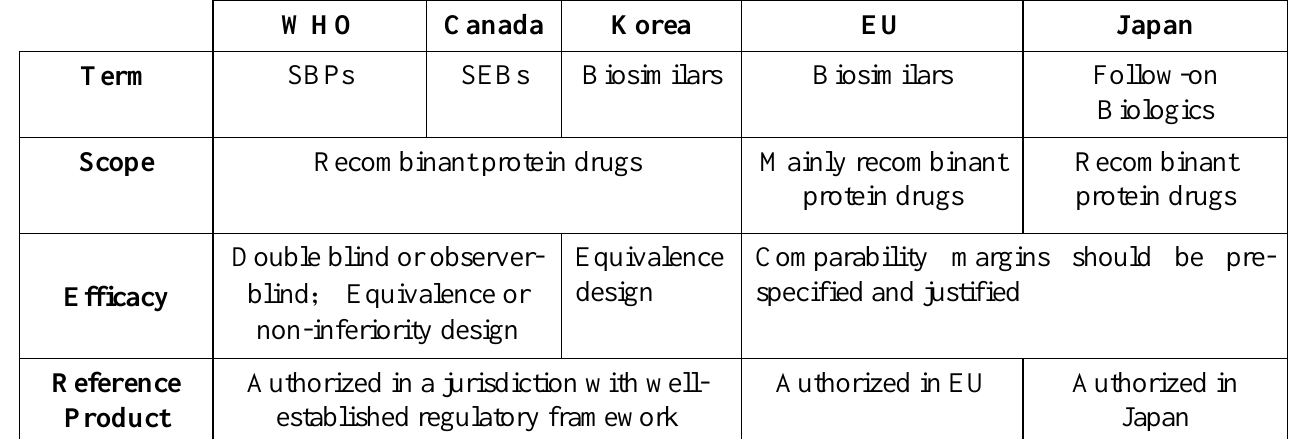
Table 2. Comparison of requirements for the evaluation of SBPs between different